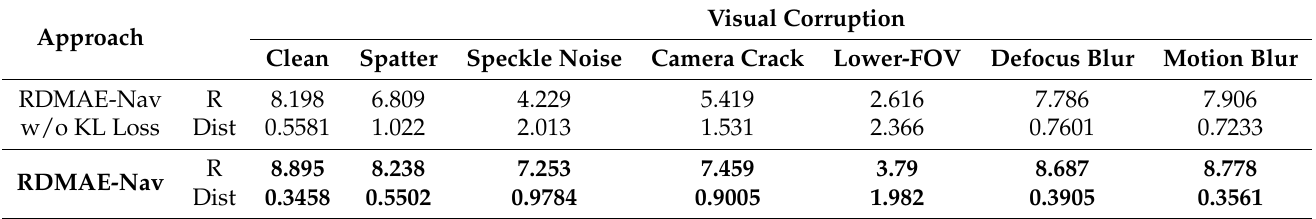
Table 4. Contributions of KL Loss on the navigation behavior of RDMAE-Nav by comparing R and Dist